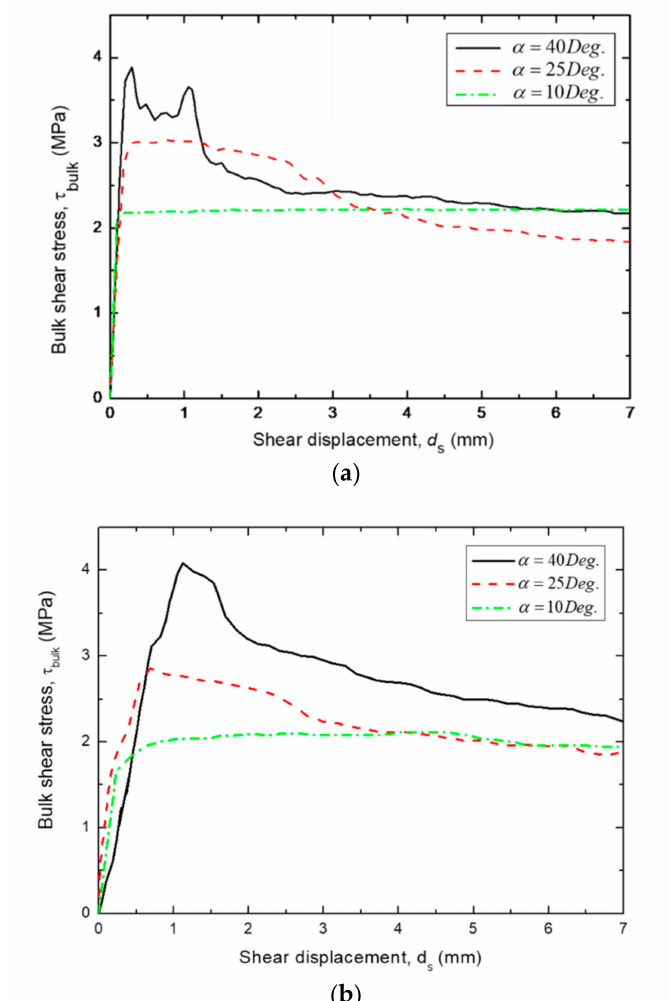
Figure 15. Shear stress–shear displacement curves obtained during a direct shear test of the rough concrete–rock joint under various asperity roughness angles for α ( a ) numerical simulation result and ( b ) experiment result. ( σ n = 2.0